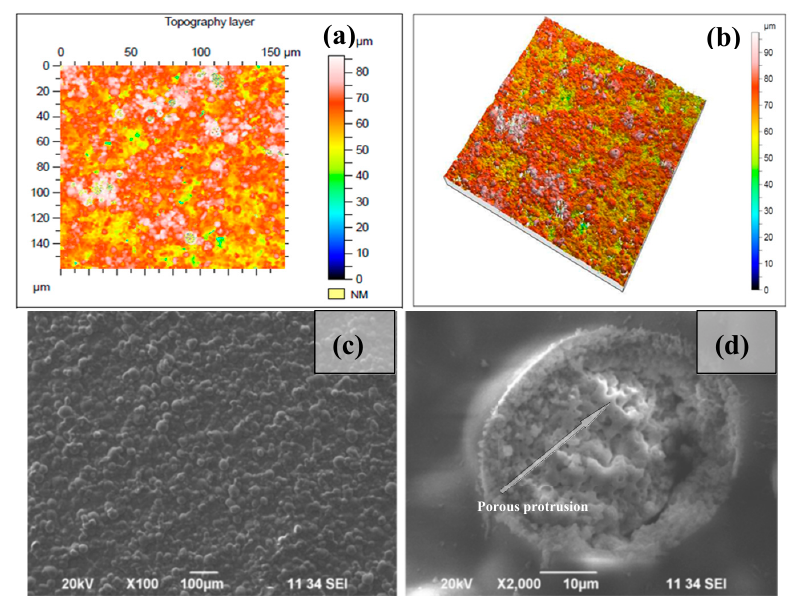
Figure 5. Thin 30/70% Ch/HAp biocomposite layers: ( a ) 150 µ m × 150 µ m area topography image, ( b ) 3-D topography confocal image of non-treated surface; ( c ) SEM image of non-treated surface; ( d ) laser irradiated surface with N = 1, I = 7.9 × 10 15 W/cm 2 .